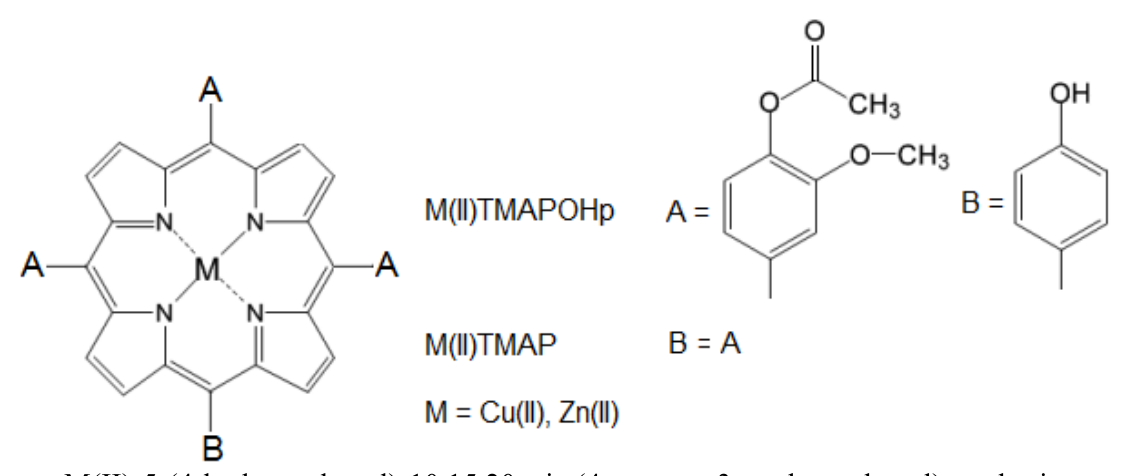
Figure 1. General structures of the mesoporphyrinic complexes used in this